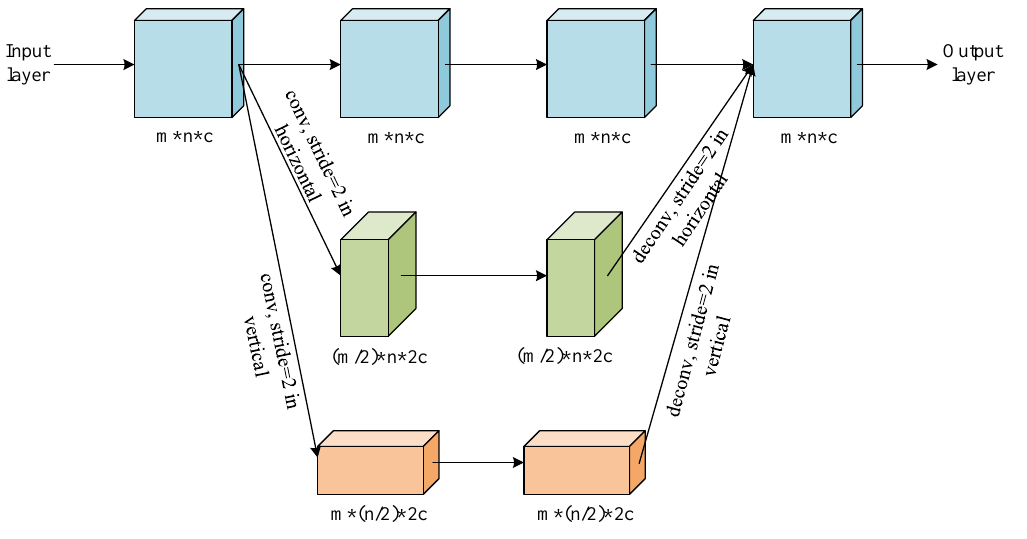
Figure 11. The multi-resolution feature concatenation module of the proposed determination sub-network.